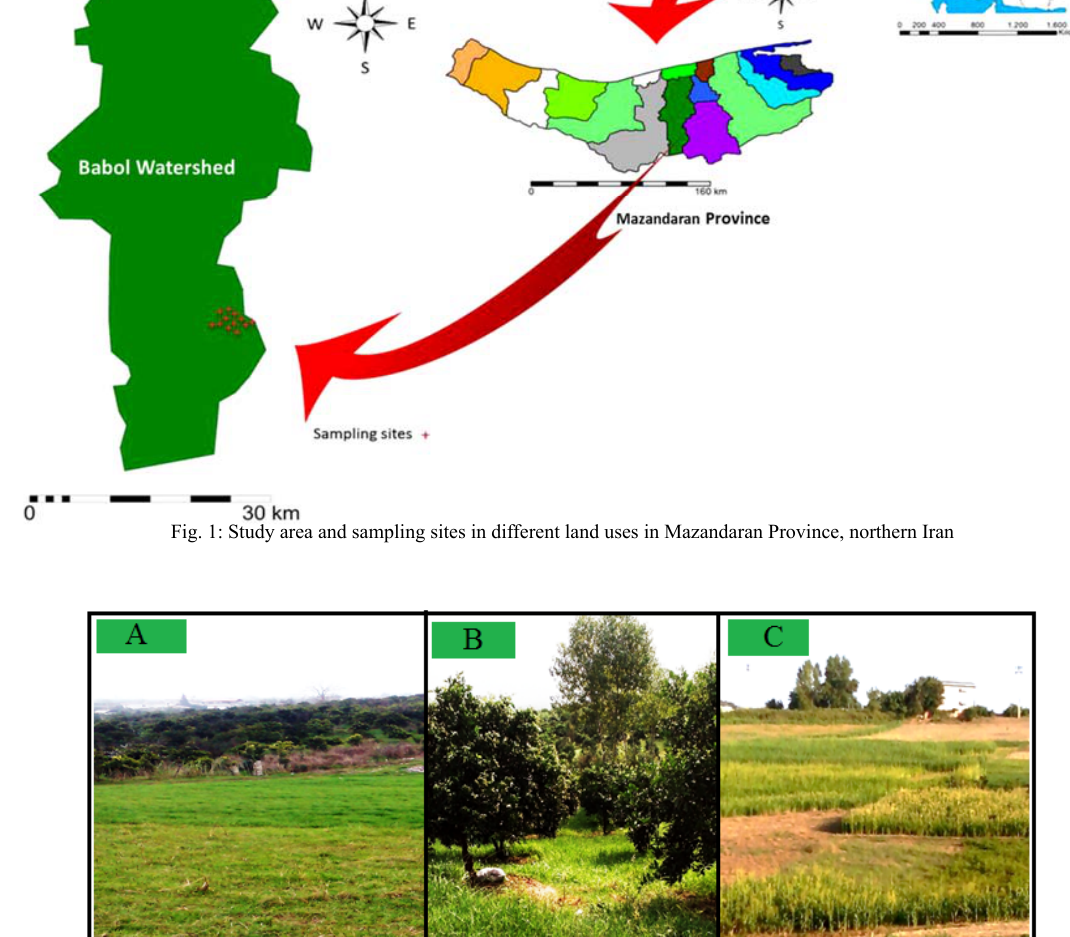
Fig. 2: Overviews of the three land uses including rangelands (A), orchards (B) and rainfed farming land (C)